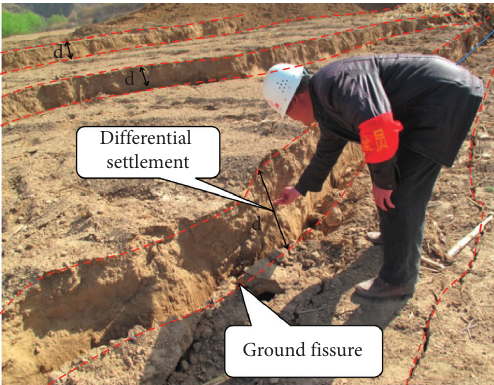
Figure 8: Ground fissure and differential settlement.